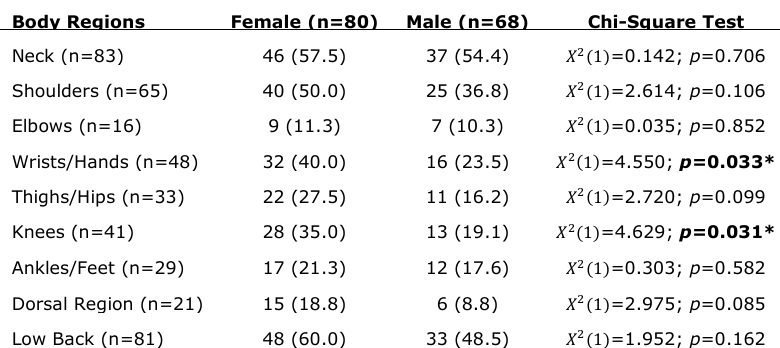
Table 2. Association between musculoskeletal symptoms and gender